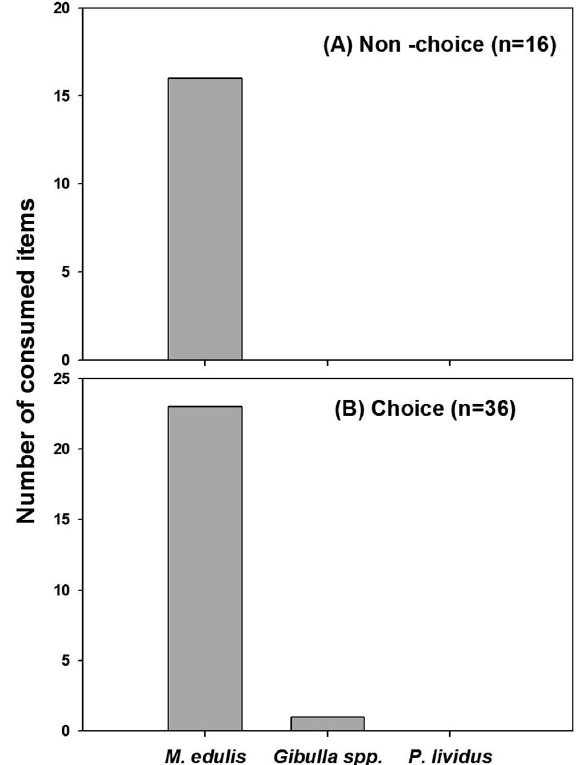
F ig . 7. – Number of consumed preys for (a) no-choice and (b) choice feeding